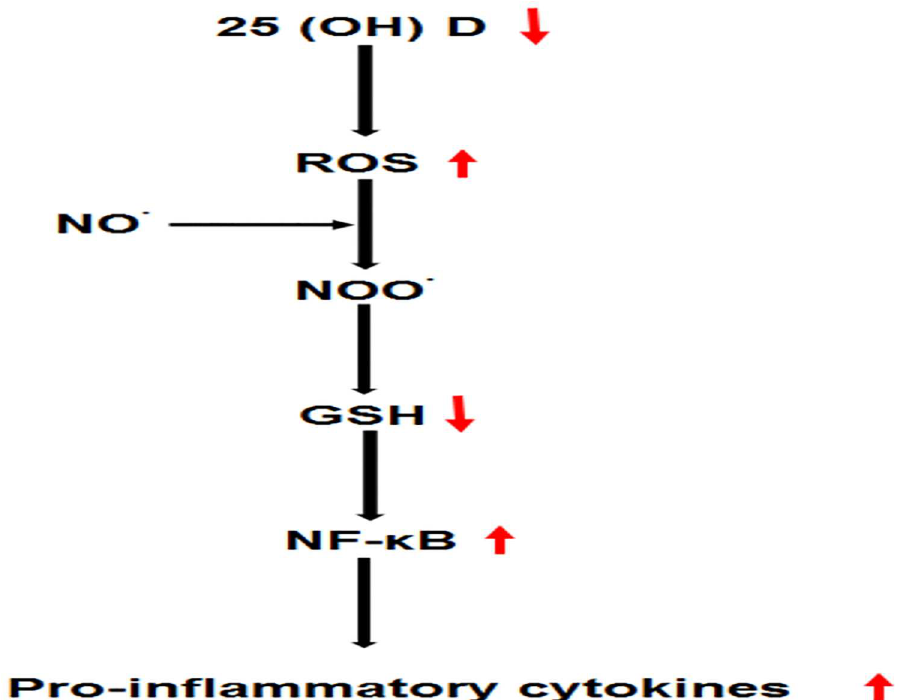
Fig 5. Schematic diagram showing 25 (OH) D mediated production of inflammatory cytokines. 25 (OH) D regulatesthe formation of reactive oxygen species, therefore a decreasein 25 (OH) D favours the ROS formation. ROS along with nitric oxide forms highly reactive peroxynitritewhich has the potentialto deplete antioxidants. As a result redox balanceis disturbed thus favouring the formation of pro-inflammatory cytokines due to activation of signallingpathways(NF- κ